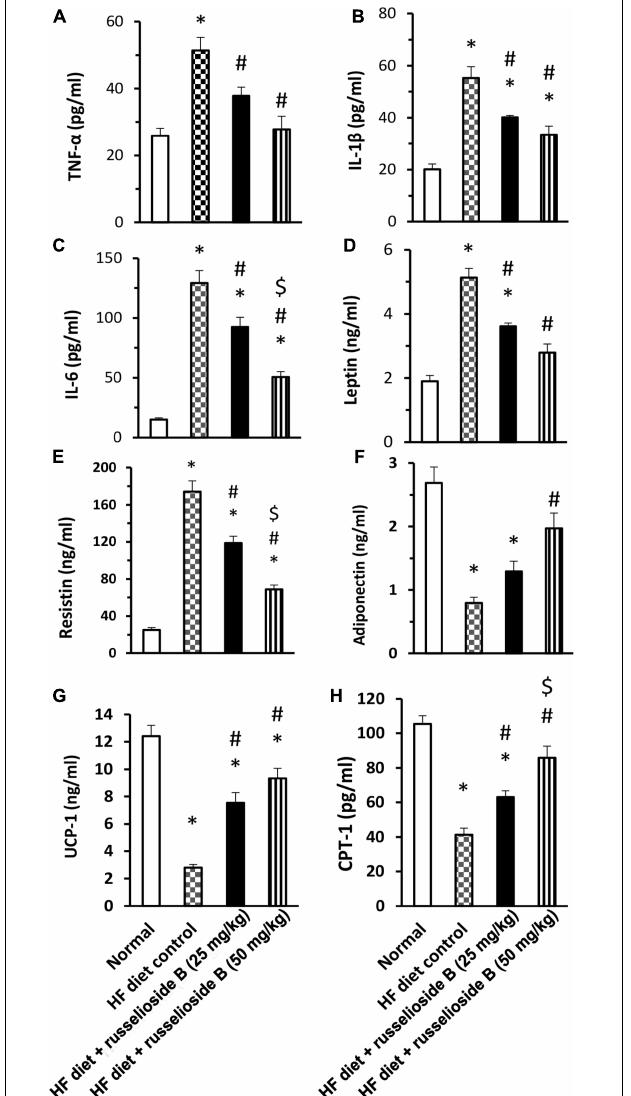
FIGURE 2 | Effect of russelioside B on serum level of adipokines and inflammatory cytokines in high fat diet fed rats. (A) TNF- α ; (B) IL-1 β ; (C) IL-6; (D) leptin; (E) resistin, (F) adiponectin, (G) uncoupling protein-1, and (H) carnitine palmitoyl transferase-1 in the study groups. Data are expressed as mean ± SE. ∗ significant versus normal group, # significant versus HF diet control group, and $ significant versus HF diet + russelioside B (25 mg/kg) group. Comparison was set by one-way ANOVA and Bonferroni’s test at P < 0.05.